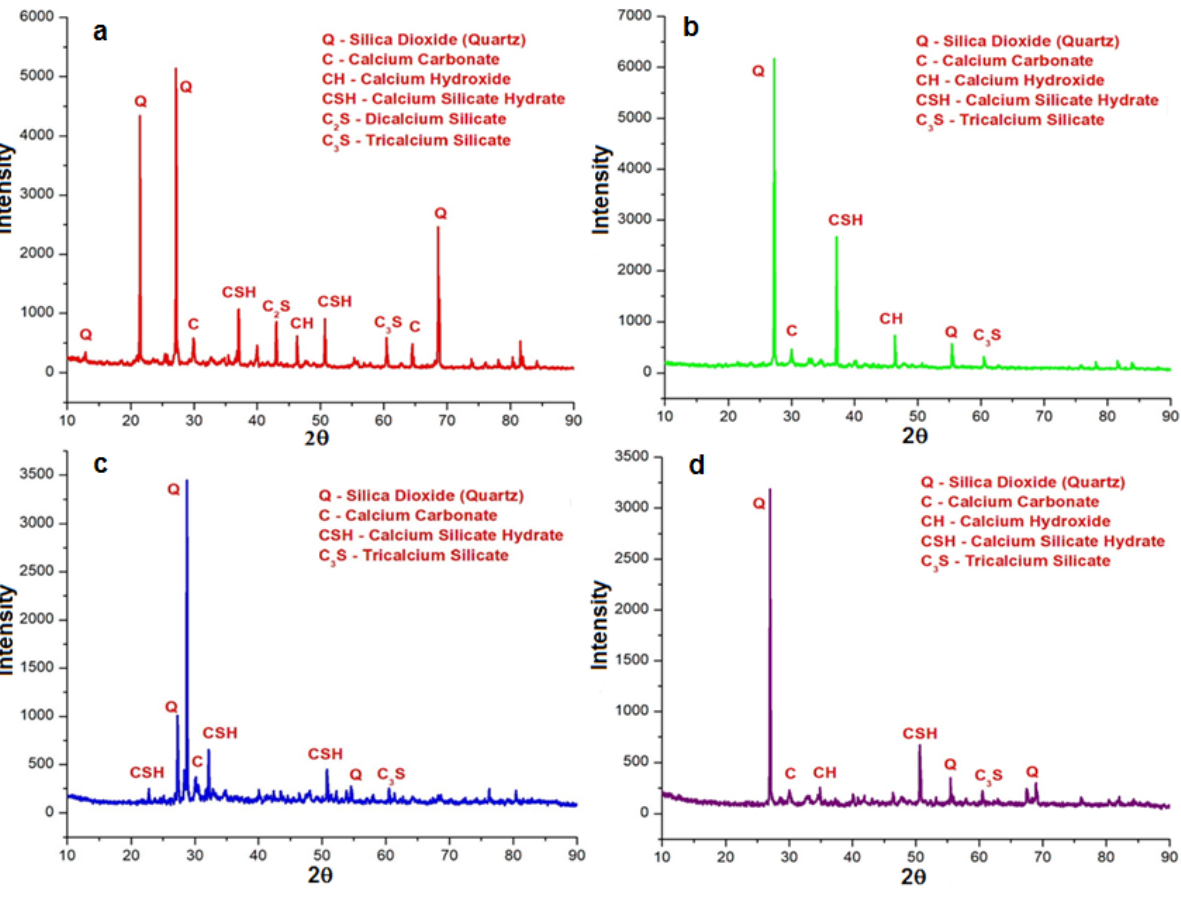
Figure 20. XRD pattern of ( a ) Fine silica sand concrete, ( b ) Coarse silica sand concrete, ( c ) River sand concrete, and ( d ) M sand concrete.